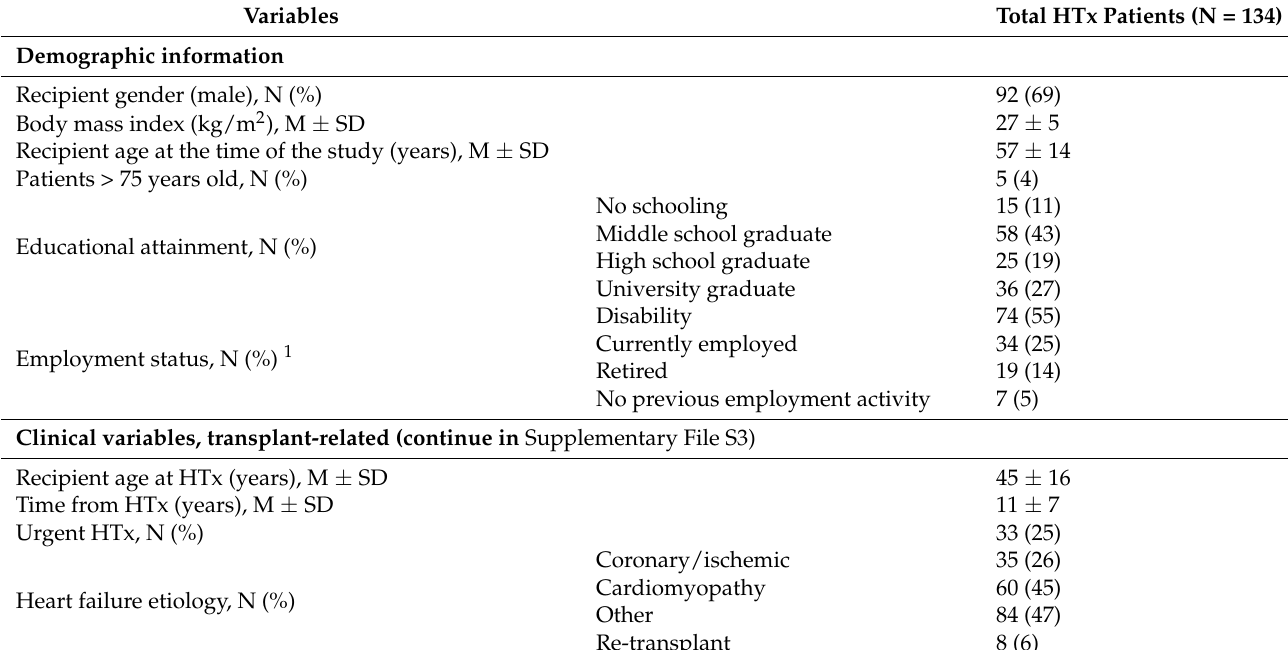
Table 1. Demographic and clinical